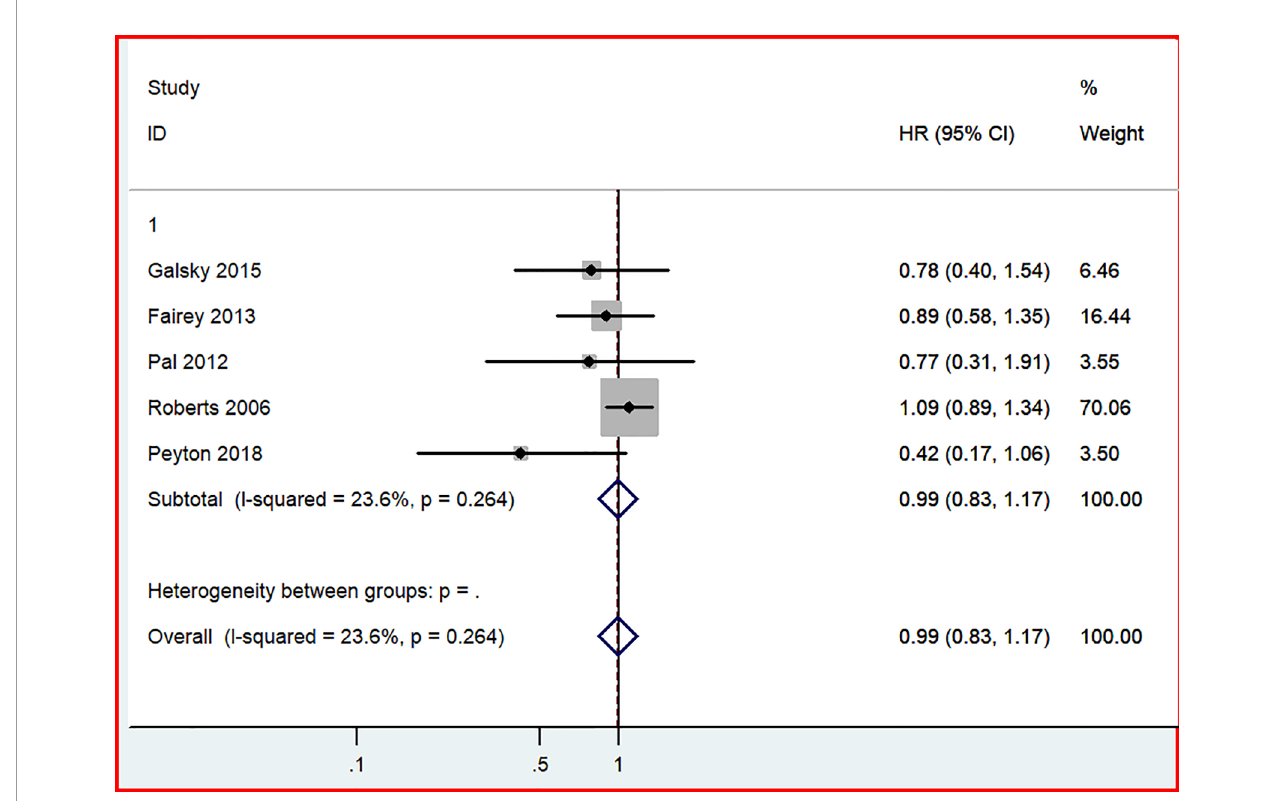
FIGURE 7 | Forest plot of overall survival in comparison of GC versus MVAC.